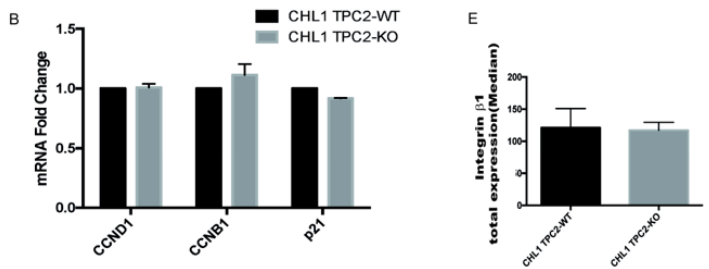
Figure 2. TPC2 KO impairs cell adhesion to collagen type I matrix. ( A ) Cell cycle analysis at 24, 48, and 72 h of CHL1 WT and TPC2 KO cells. ( B ) qPCR analysis of cell cycle markers CCND1, CCNB1 and p21; H3 was used as an internal control. ( C ) Adhesion assay on collagen type I matrix, cells stained with crystal violet. ( D ) Flow cytometric detection of α 2 β 1 integrin chain in CHL1 WT and TPC2 KO cells. ( E ) Flow cytometric detection of Integrin- β 1 on CHL1 WT and TPC2 KO fixed and permeabilized cells. Data in bar charts represent the mean ± s.e.m. of three independent experiments (* p < 0.05; ** p < 0.01; *** p < 0.001).